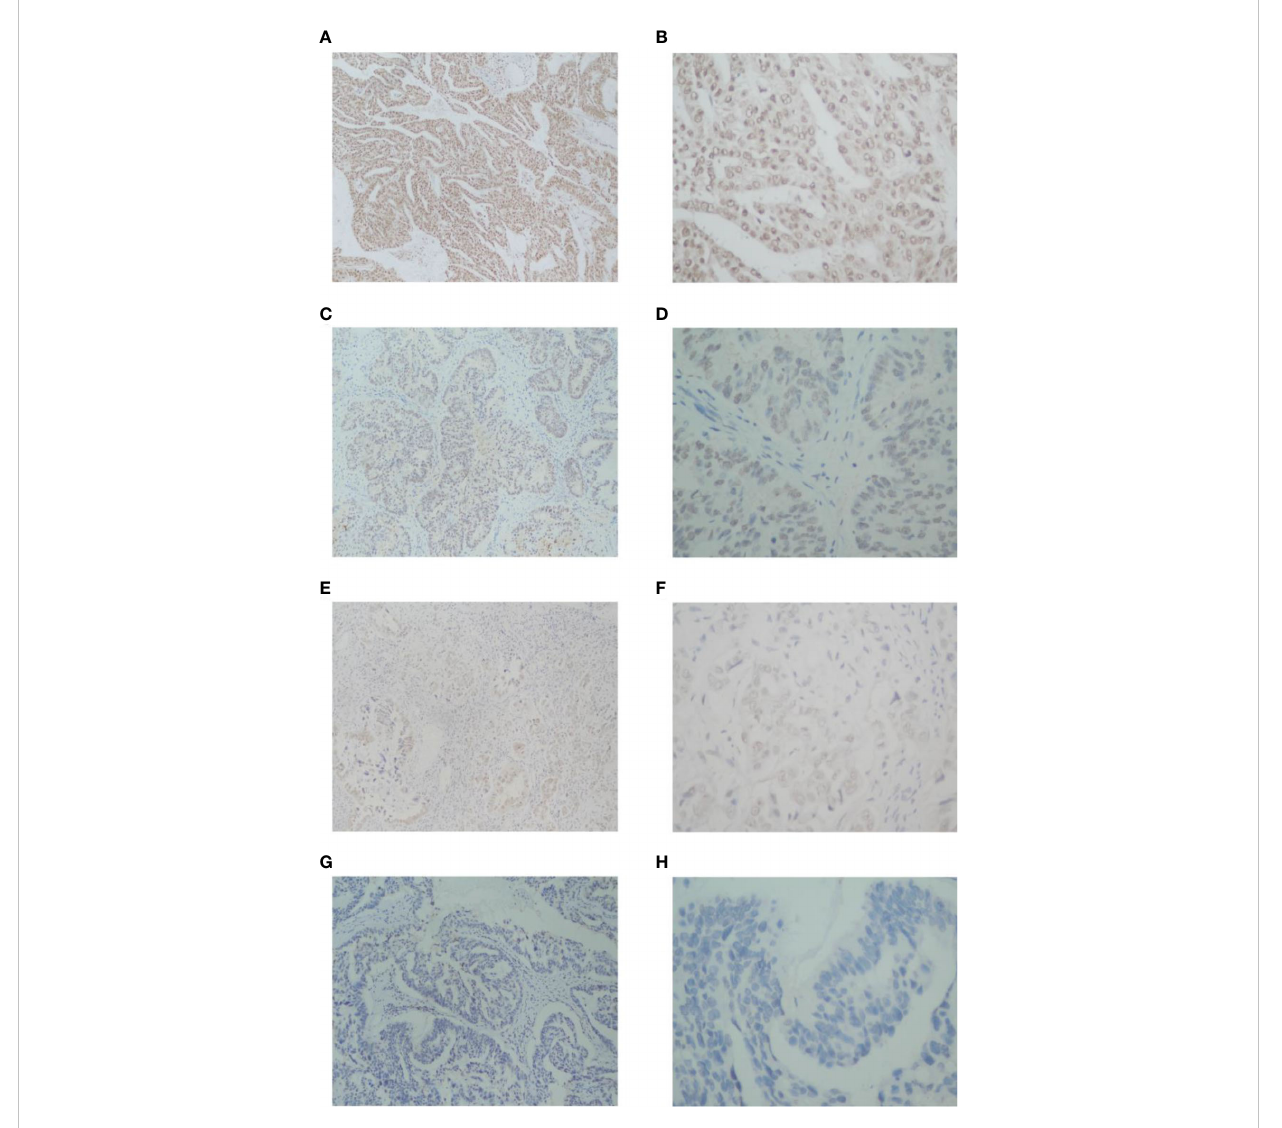
FIGURE 1 Immunohistochemistry analysis of NCOA5 in EOC tissue specimens. The representative pictures +++ ( A : ×100, B : ×400),++ ( C : ×100, D : ×400),+ ( E : ×100, F : ×400) and -( G : ×100, H :